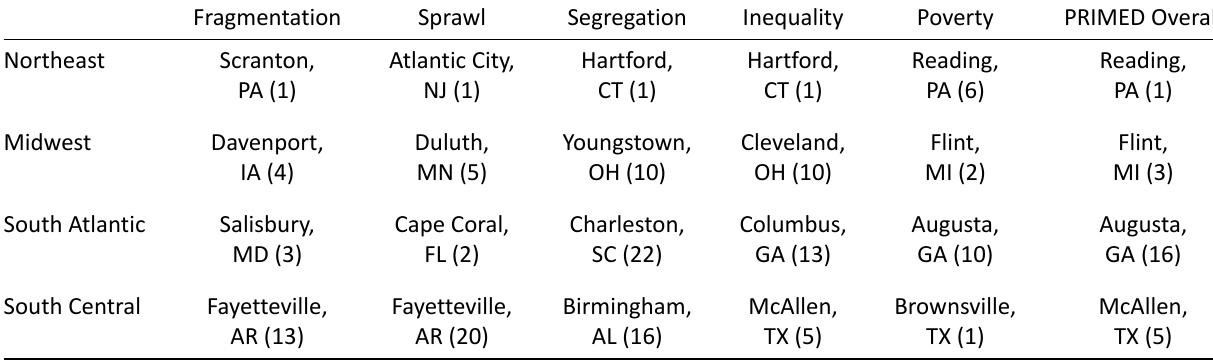
Table 2. Highest scoring urban regions by census grouping (overall rank in parentheses).